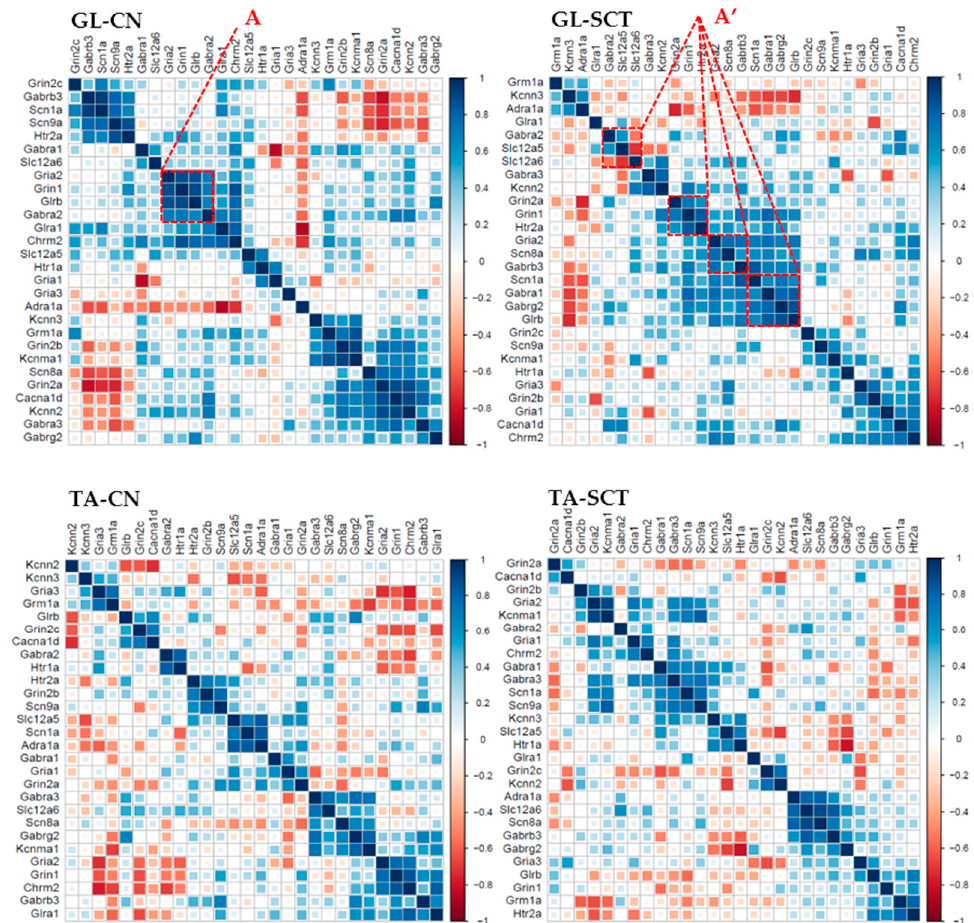
Figure 8. Changes in clustered correlated gene expression as a result of SCI in GL and TA MNs. The order of the genes along the X- and Y-axis of each correlogram are automatically clustered depending on the R-values of the genes.